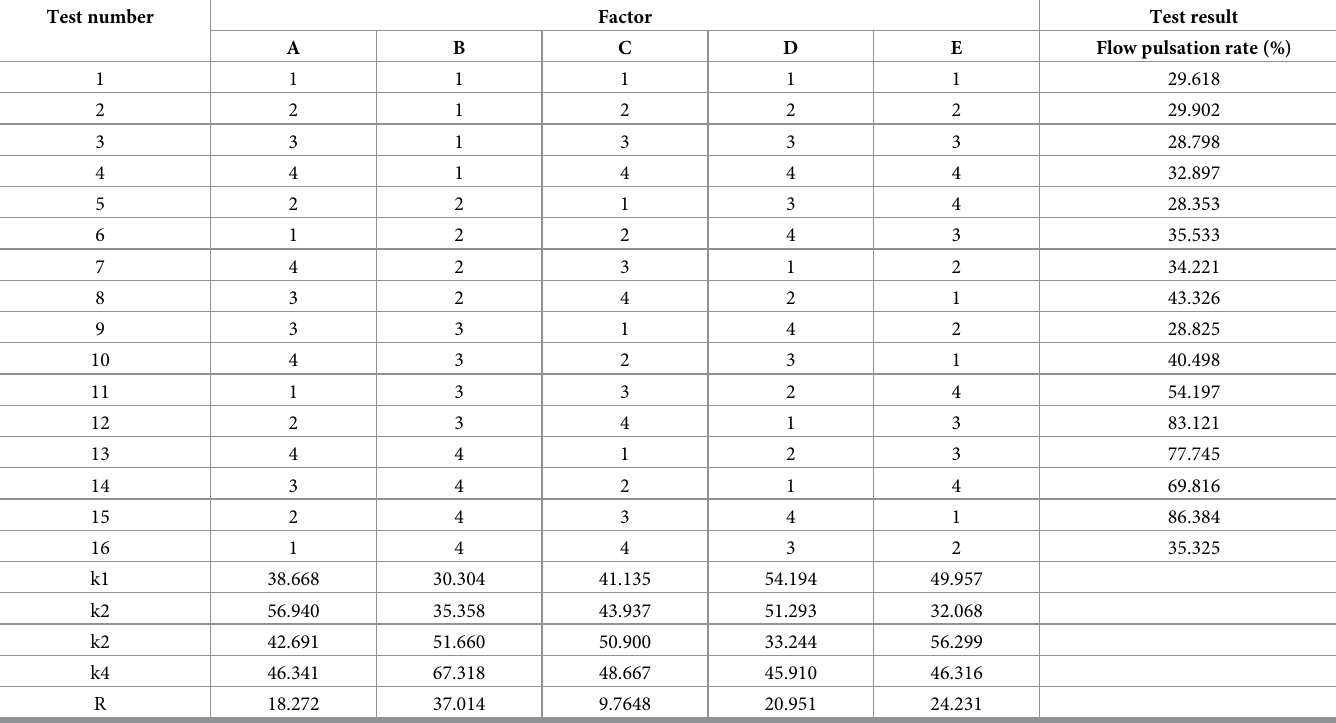
Table 7. Orthogonal test analysis table of flow pulsation